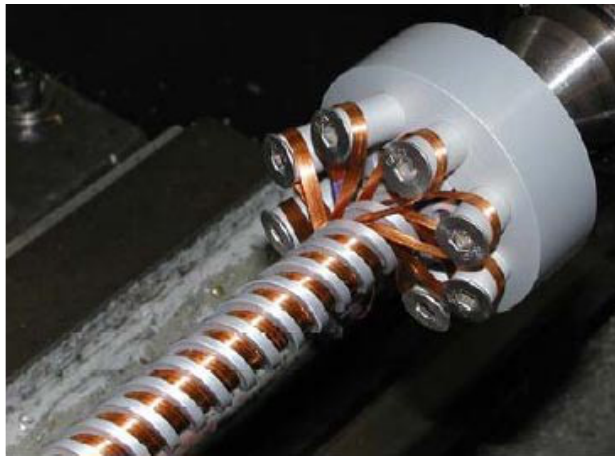
FIG. 9. (Color) Photograph of undulator winding showing the return pegs to allow for continuous